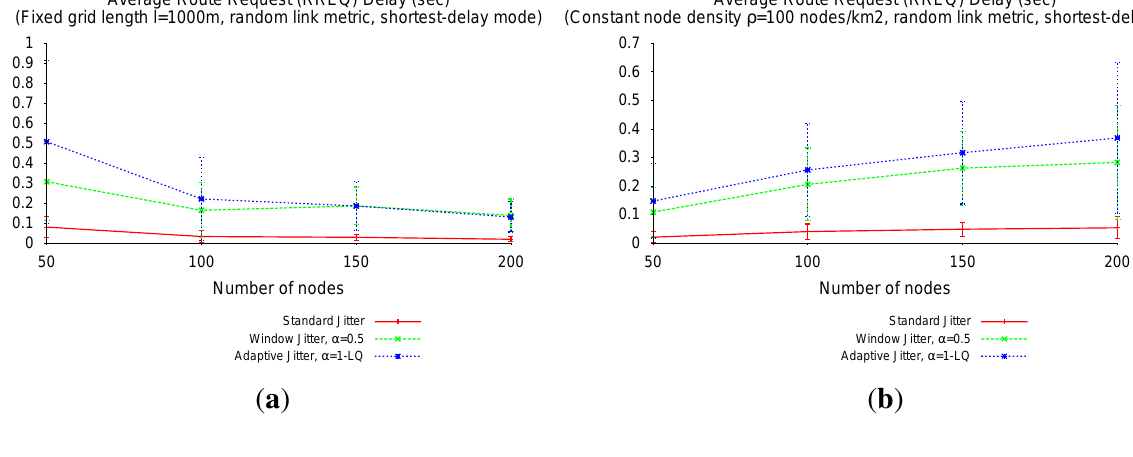
Figure 12. Route discovery delay, shortest-delay RREQ